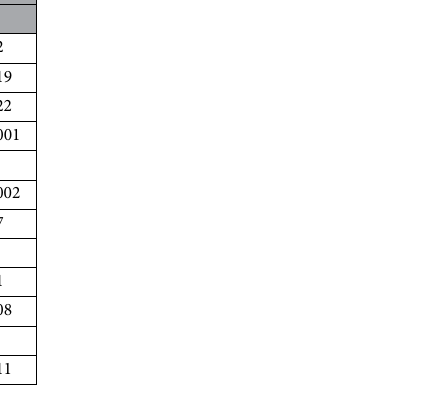
Table 3. Comparison between TM and